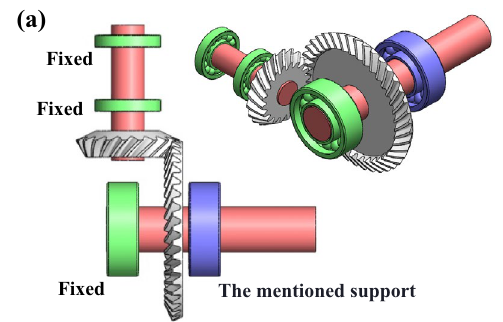
Fig. 1 Diagram of the supporting form a case-1 and b case-2